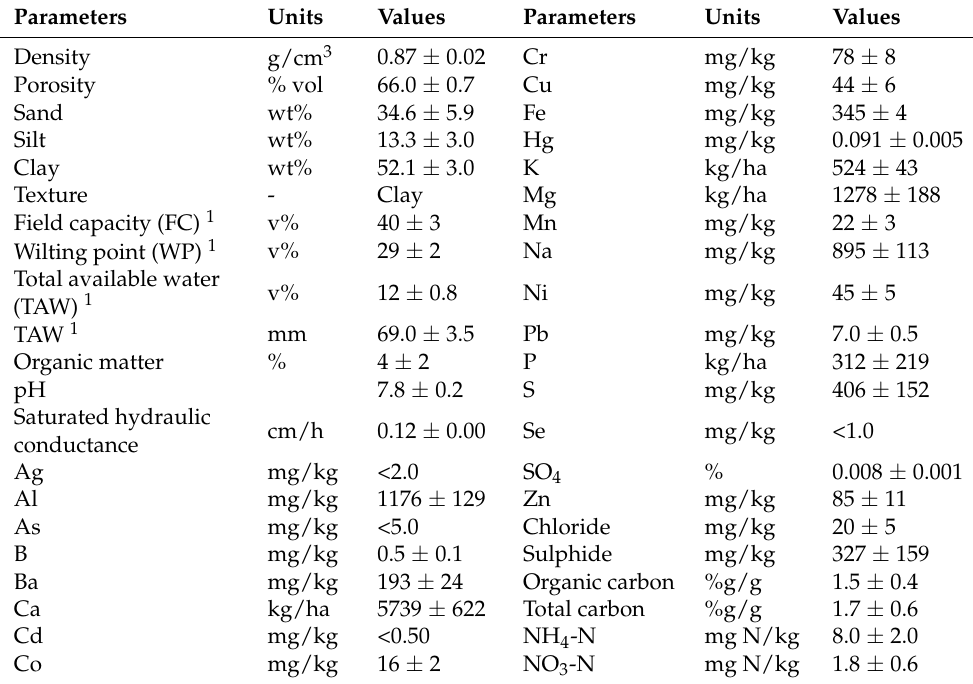
Table 5. Soil physical and chemical properties at a depth 0–30 cm (n = 16, July 2019). Parameters